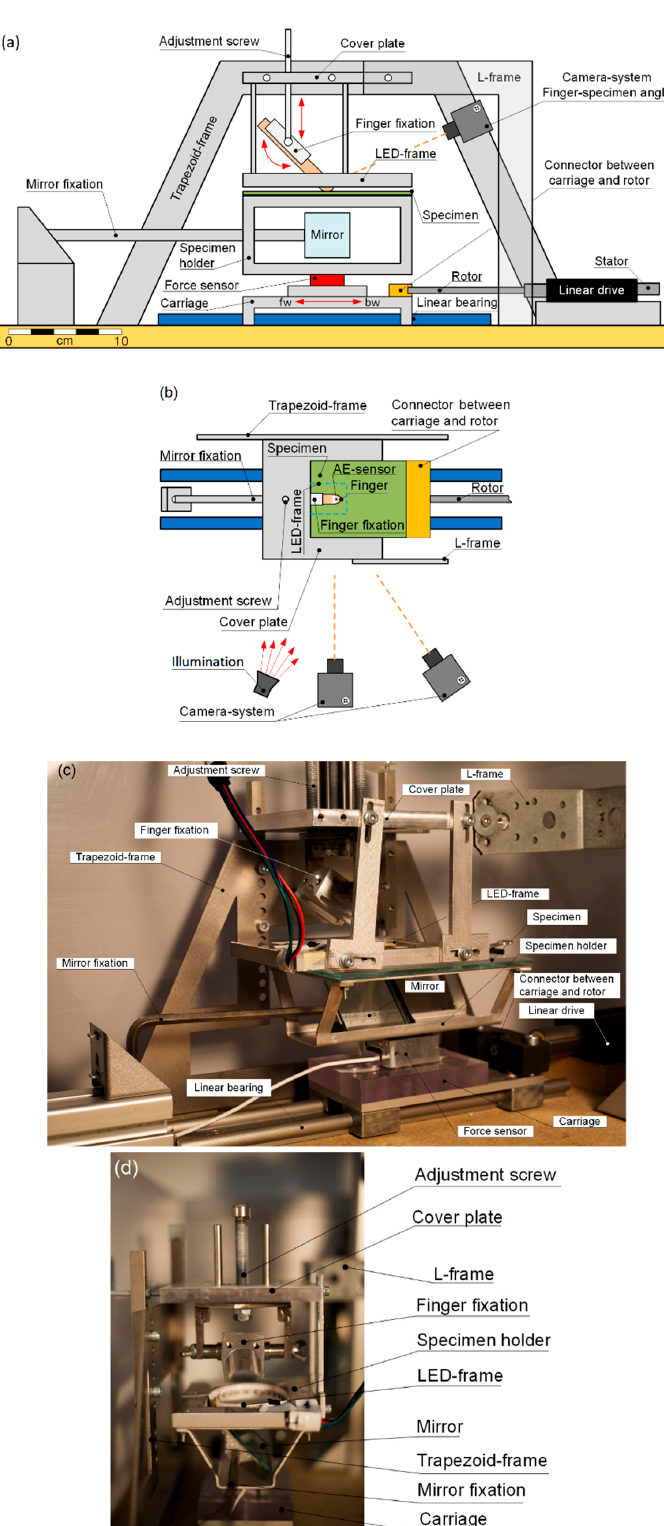
Figure 1. ( a ) Schematic side view illustration of the experimental setup. The horizontal red double arrow indicates the directions of movement. The abbreviations denote the forward (fw) and backward (bw) motion respectively. ( b ) A schematic top view of the experimental setup visualizing the camera and illumination positions. ( c ) A side view of the setup and ( d ) the front view of the setup.